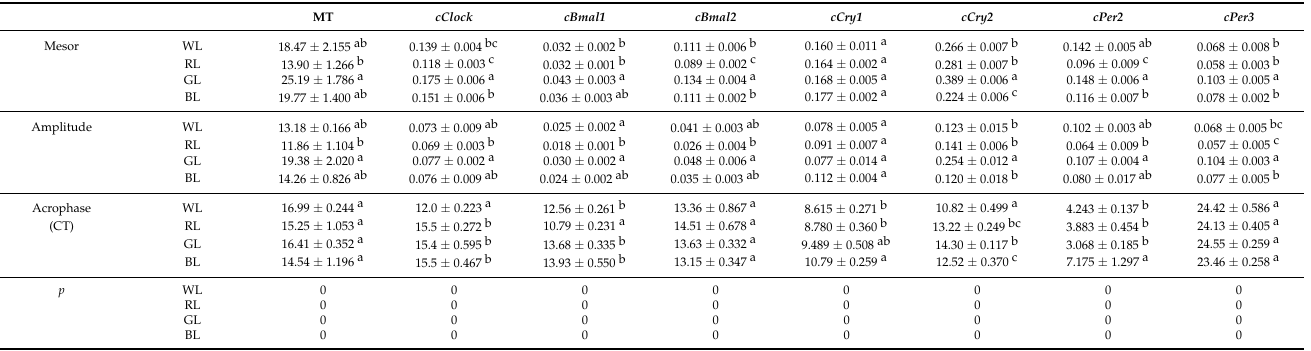
Daily temporal differences were analyzed by SPSS 20 with one-way ANOVA. Rhythm parameters (mesor, ampli- tude, acrophase) were generated by Originlab Software 9.3, and were shown as the mean ± SEM. MT: melatonin; Different letters indicate significant differences among the monochromatic light groups.